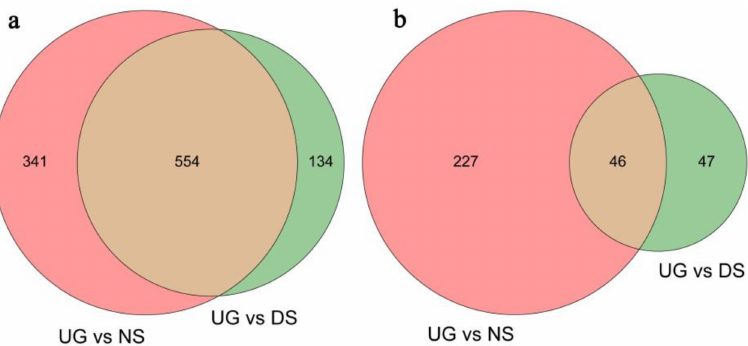
Figure 1. Comparative analysis of transcriptome changes in maize embryos in response to different sowing conditions. Venn diagram constructed using the DEGs with changes of more than two folds and FDR values of less than 0.05. ( a , b ) Number of upregulated and downregulated DEGs, respectively, related to